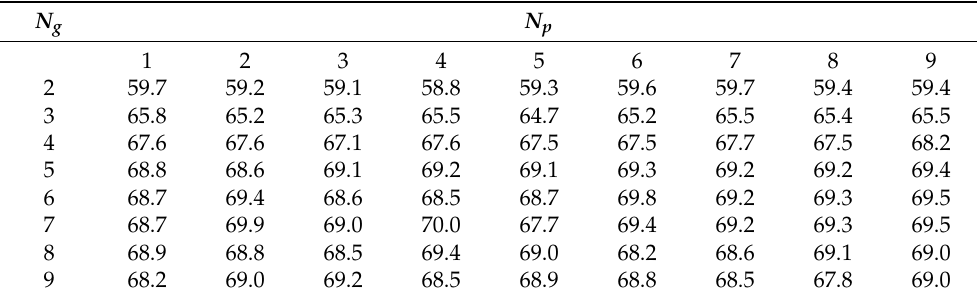
Table 4. Percentages of data sets with R P ≥ 0.8.